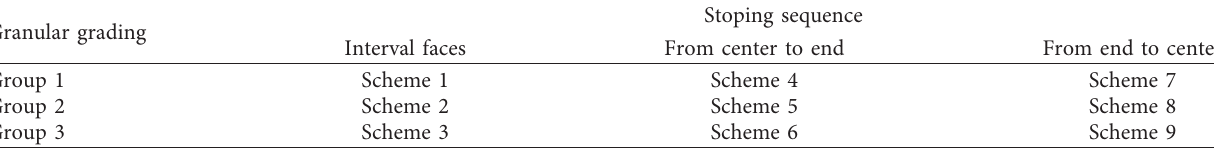
Table 3: Summary of laboratory schemes.